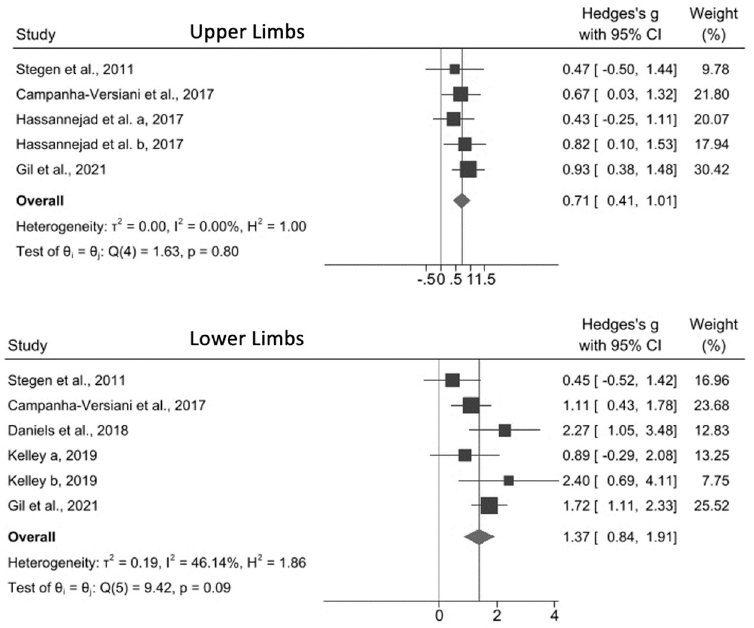
Fig 3. Effect size of physical exercise on muscle strength in adults following bariatric surgery according to the repetition maximum test. Hassanejad et al. a, 2017: aerobic training; Hassanejad et al. b, 2017: aerobic and resistance training; Kelley a, 2019: resistance eccentric; Kelley b, 2019: resistance